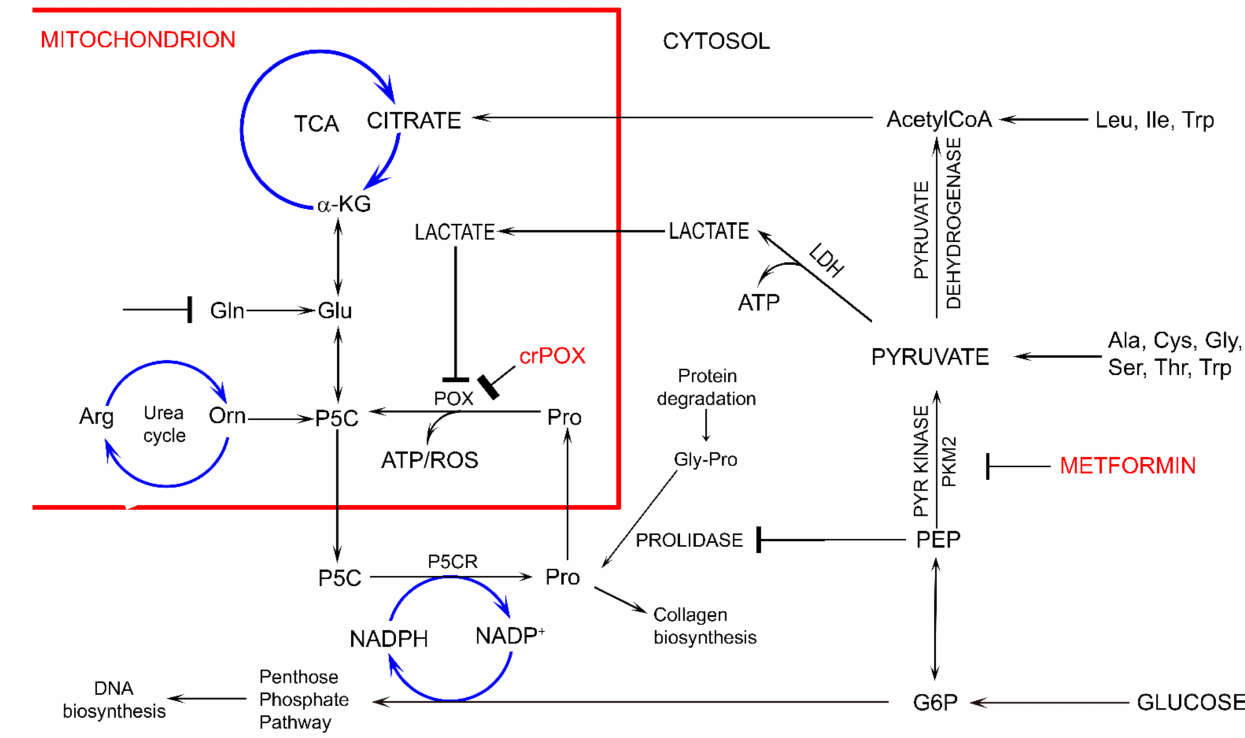
Figure 2. The potential effect of metformin (MET) on complex regulatory mechanisms of PRODH/POX-dependent apopto- sis/survival linking glycolysis, TCA, urea cycles, pentose phosphate pathway, proline cycle (synthesis and degradation), collagen biosynthesis and degradation and prolidase. α -KG— α -ketoglutarate, AcetyloCoA—acetyl coenzyme A,